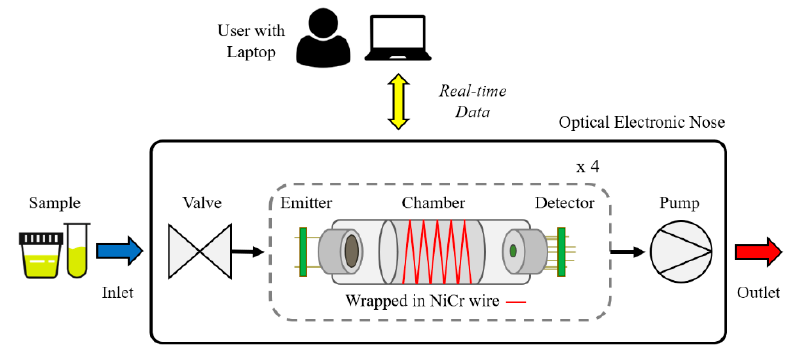
Figure 1. Optical electronic nose system diagram.